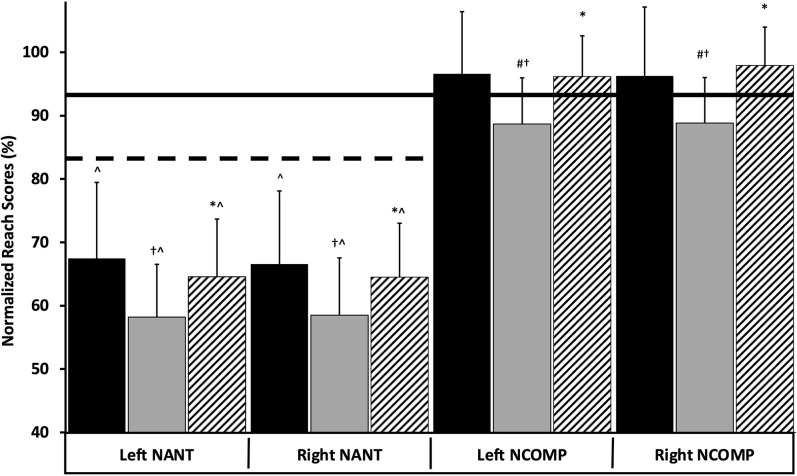
Left and right normalized anterior reach (NANT) and normalized composite scores (NCOMP) scores expressed as percentages and displayed across the competitive season [PRE-season (black), MID-season (gray) POST-season (striped)]. (†) indicates a statistically significant change from PRE-season (p < 0.05). (*) indicates a statistically significant change from MID-season (p < 0.05). (#) indicates failure to meet the NCOMP relative injury risk threshold = [(ANT+PTL+PTM) <94% of (limb length*3)] which is visually represented by the solid horizontal line (Plisky et al., 2006). (∧) indicates failure to meet the NANT relative injury risk threshold = (ANT reach distance <84% of limb length), which is visually represented by the dashed horizontal line (Plisky et al., 2006; Gonell et al., 2015; Stiffler et al., 2017). ANT, anterior; PTL, posterior lateral; PTM, posterior medial.